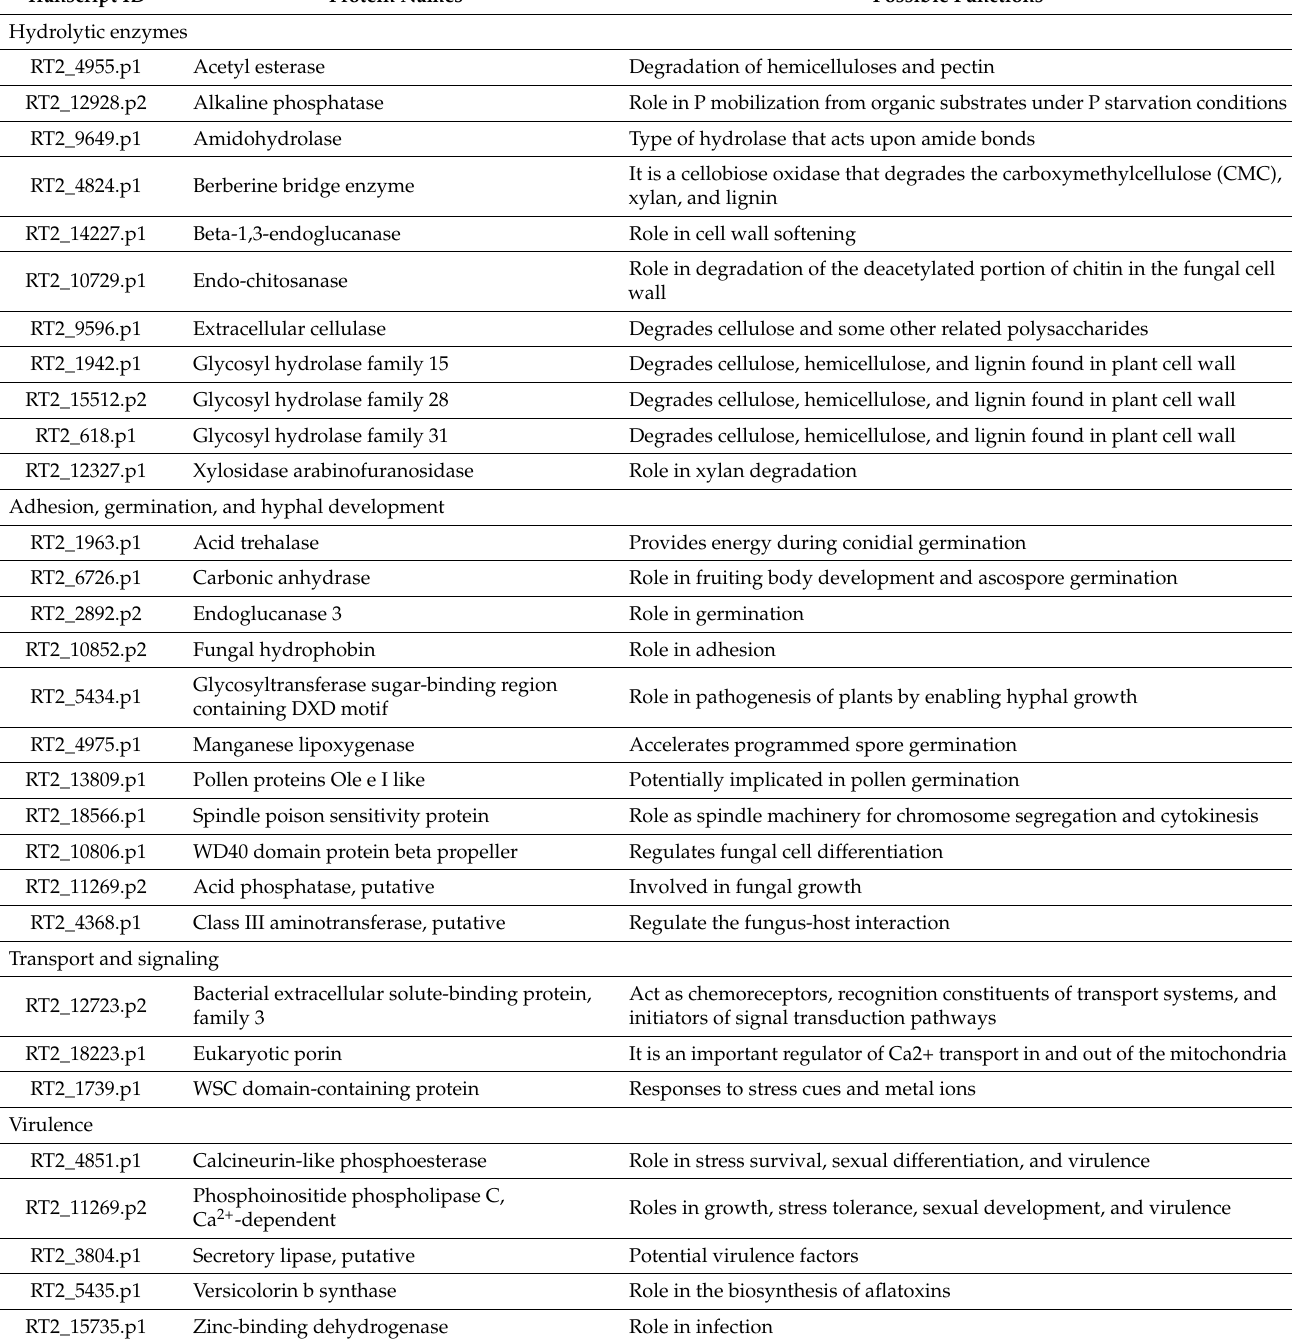
Table 4. Uniquely expressed secretory effector proteins during GT formation in C. gloeosporioides